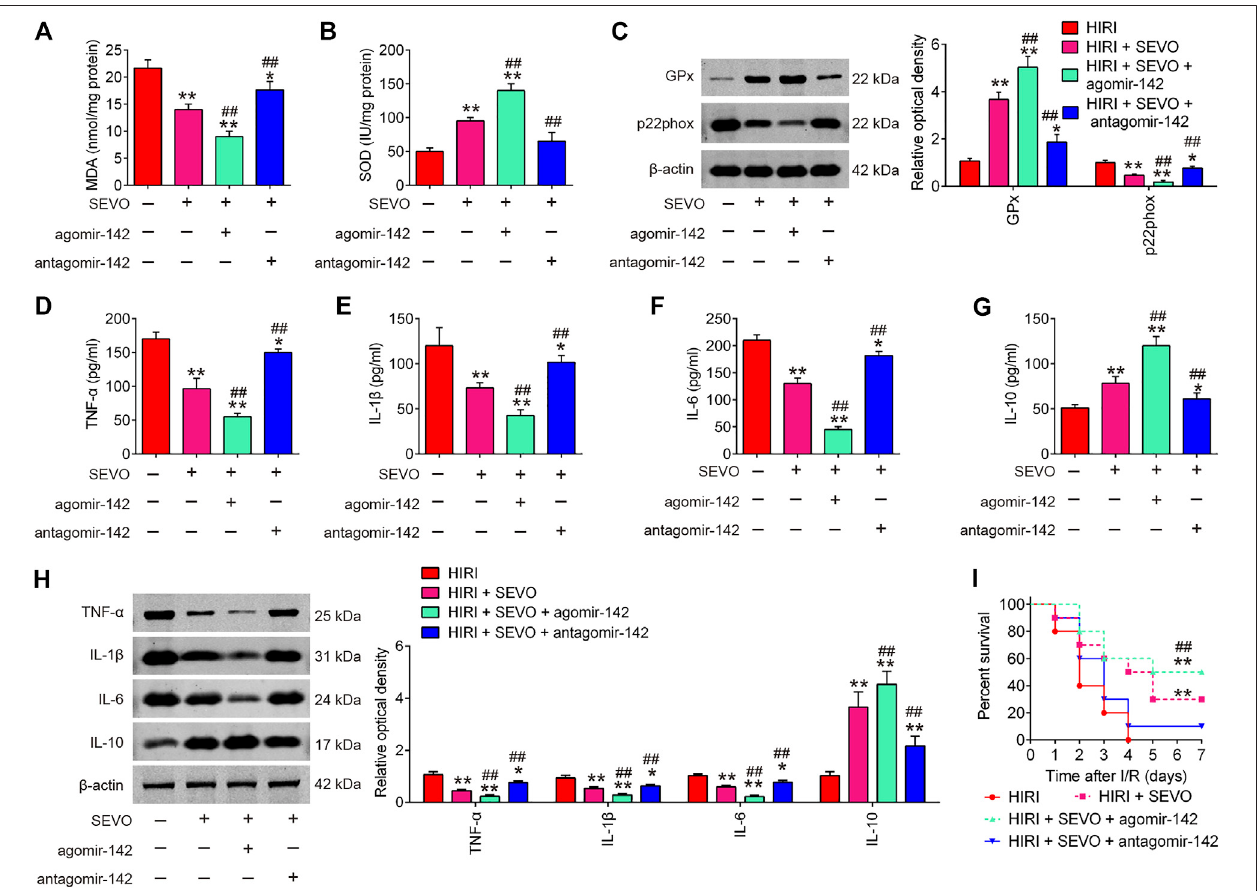
FIGURE 5 | Sevo fl urane postconditioning attenuates oxidant stress and in fl ammatory response through regulation of miR-142. The agomiR-142 and antagomiR- 142 were injected into mice, and then the mice were subjected to ischemia, post-treatment with inhalation of 2% Sevo for 2 h immediately at the onset of reperfusion. (A, B) The contents of MDA and SOD were measured by ELISA assays ( n (cid:2) 6/group). (C) The expressions of GPx and p22phox were detected by Western Blot ( n (cid:2) 6/group). (D – G) The in fl ammatory cytokines including TNF- α , IL-1 β , IL-6 and IL-10, were evaluated by ELISA assays ( n (cid:2) 6/group). (H) The protein expressionsofTNF- α ,IL-1 β ,IL-6, andIL-10weredeterminedbyWestern Blot( n (cid:2) 6/group). (I) Animalsurvivalwasrecordedattheindicatedtimepoints ( n (cid:2) 10/group). Alldataweremeasurementdatawhichwereexpressedasmean ± standarddeviationandanalyzedbyone-wayanalysisofvariance.* p < 0.05,** p < 0.01vs.HIRIgroup; ## p < 0.01 vs. HIRI + Sevo